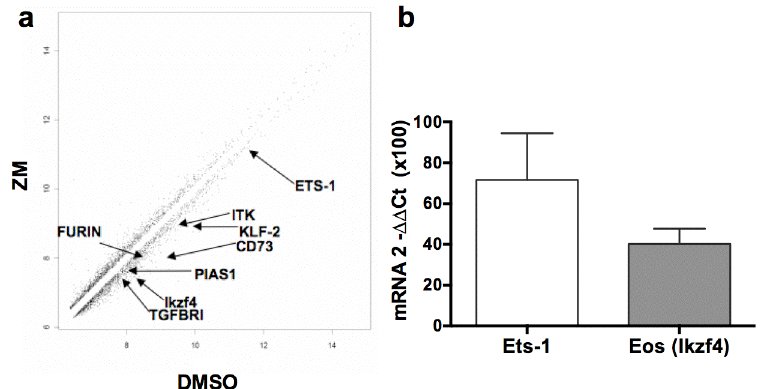
Fig 5. Molecular impact of JAK/STAT signaling inhibition in Treg. (A) Scatter plot comparison of average expression values in ZM-treated cells (ZM) versus vehicle-treated cells (DMSO) for all the 45,282 probes in expanded CD4 + GFP + T cells from Foxp3-eGFP mice treated for 2h in presence of IL-2. (B) mRNA quantification by Taqman RT-PCR on Ets-1 and Eos (Ikzf4) in 2hrs ZM-treated cells relative to control values in untreated